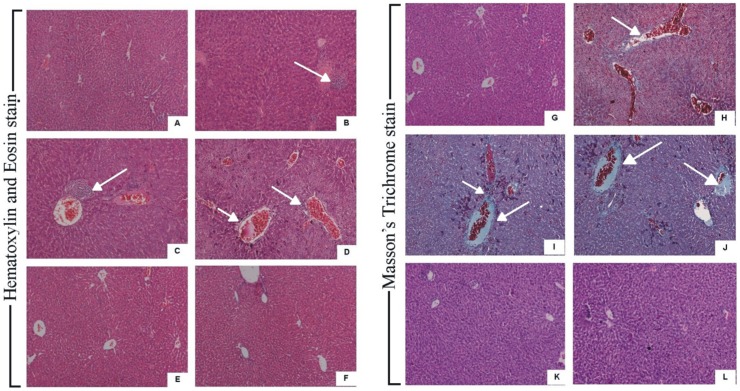
Liver tissue in antibiotic alone group showed high liver inflammatory response with infiltration of neutrophilic granulocytes (white arrow) indistinct boundaries between cytoplasm and nucleus of liver cells, hepatic portal haemorrhage and hepatocyte necrosis (white arrow) [Fig.2 (amikacin) C, I (cefotaxime) D, J] as compared to infection control (Fig.2 B, H).Uninfected group (control) did not show any sigh of inflammatory response (Fig.2 A, G). Amikacin-zingerone treatment (Fig.2 E, K) as well as cefotaxime-zingerone treatment (Fig.2 F, L) significantly protected mice from hepatic inflammation induced by antibiotic mediated endotoxemia and liver tissue appeared to be normal as was observed in control group (uninfected group).